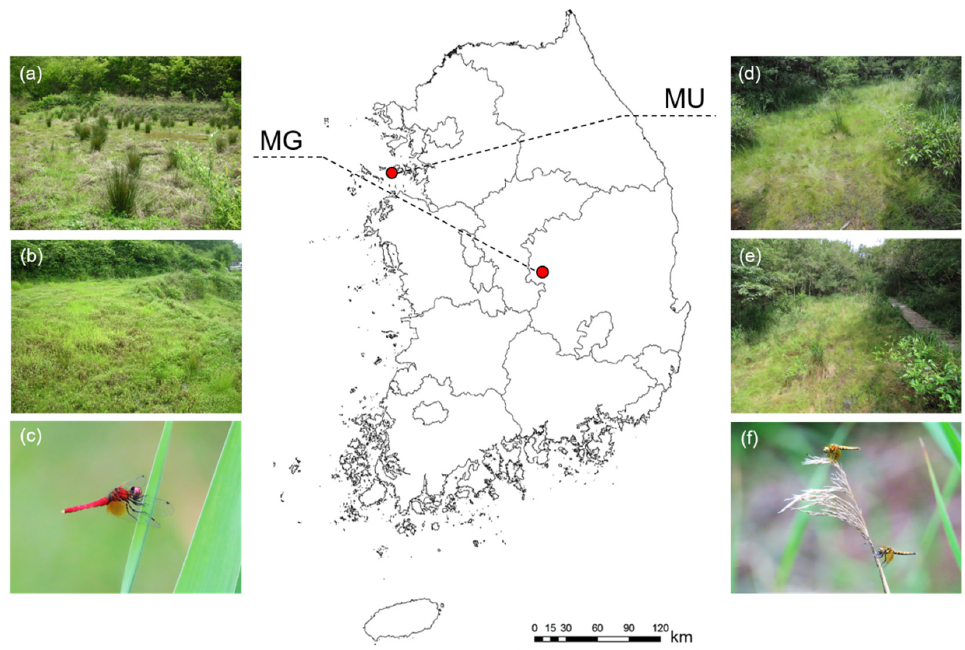
Figure 1. Two study sites selected for Nannophya koreana investigation in Korea. The first site was located in Mungyong-si (MG) (36° 33 15.9 ′ N, 128° 00 20.2 ′ E) ( a , b ) and the other site was located in Muui-do (MU) (37° 22 57.2 ′ N, 126° 24 53.4 ′ E) ( d , e ). Pictures of male ( c ) and female ( f ) adults of N. koreana .